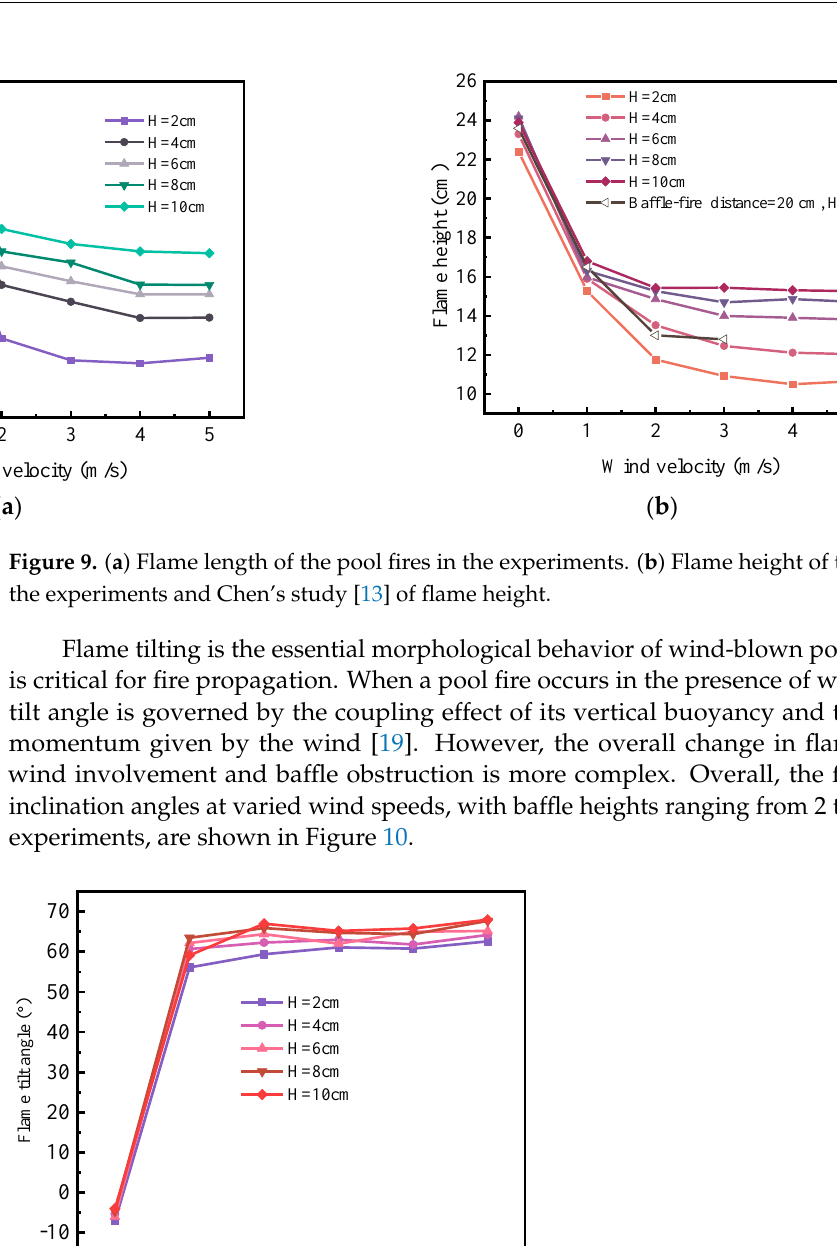
Figure 8. Flame characteristics under a 0 – 5 m/s wind velocity and a 6 cm-high baffle.